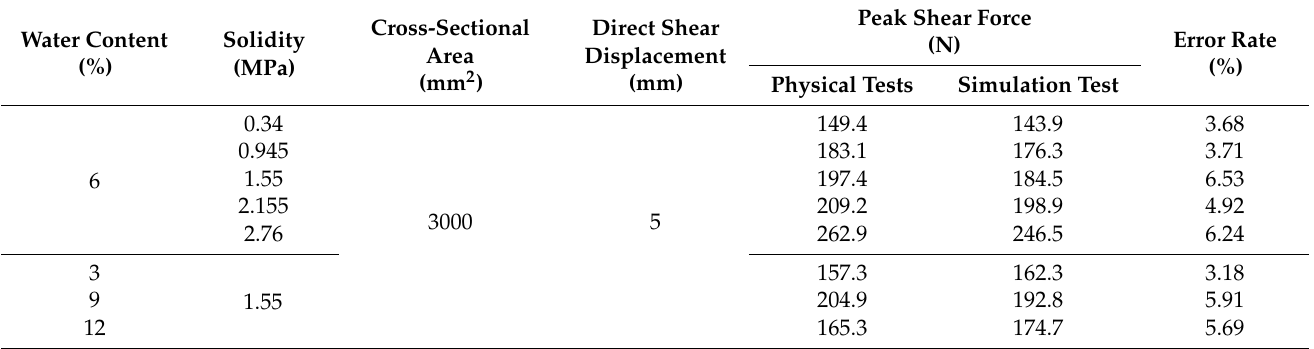
Table 12. Comparison of peak shear force under 0.1 MPa positive pressure in the direct shear